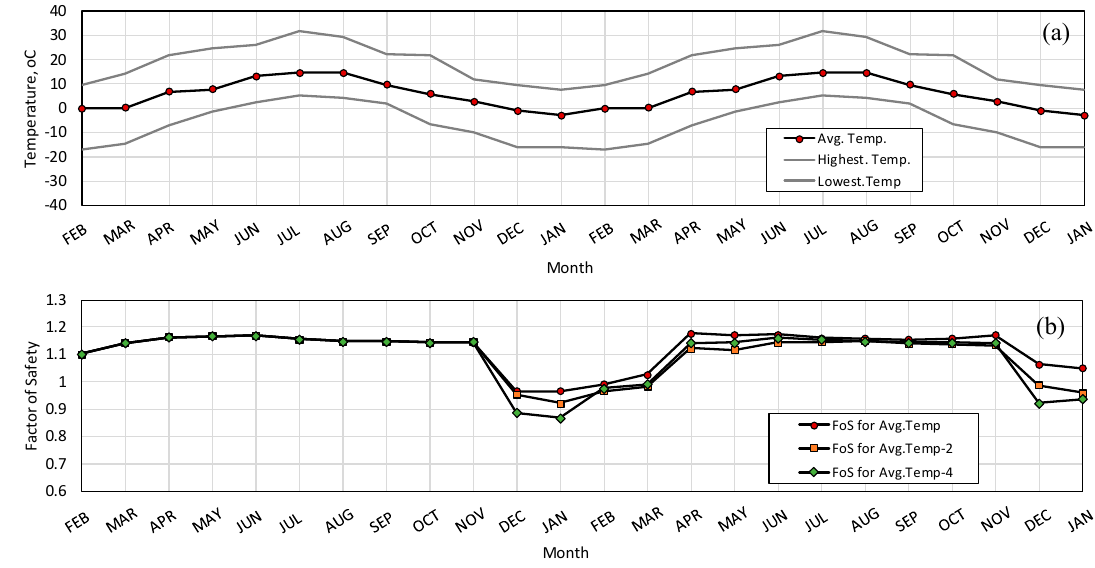
Figure 10. ( a ) Temperature distribution in 2017–2018 and ( b ) di ff erence in the factor of safety considering